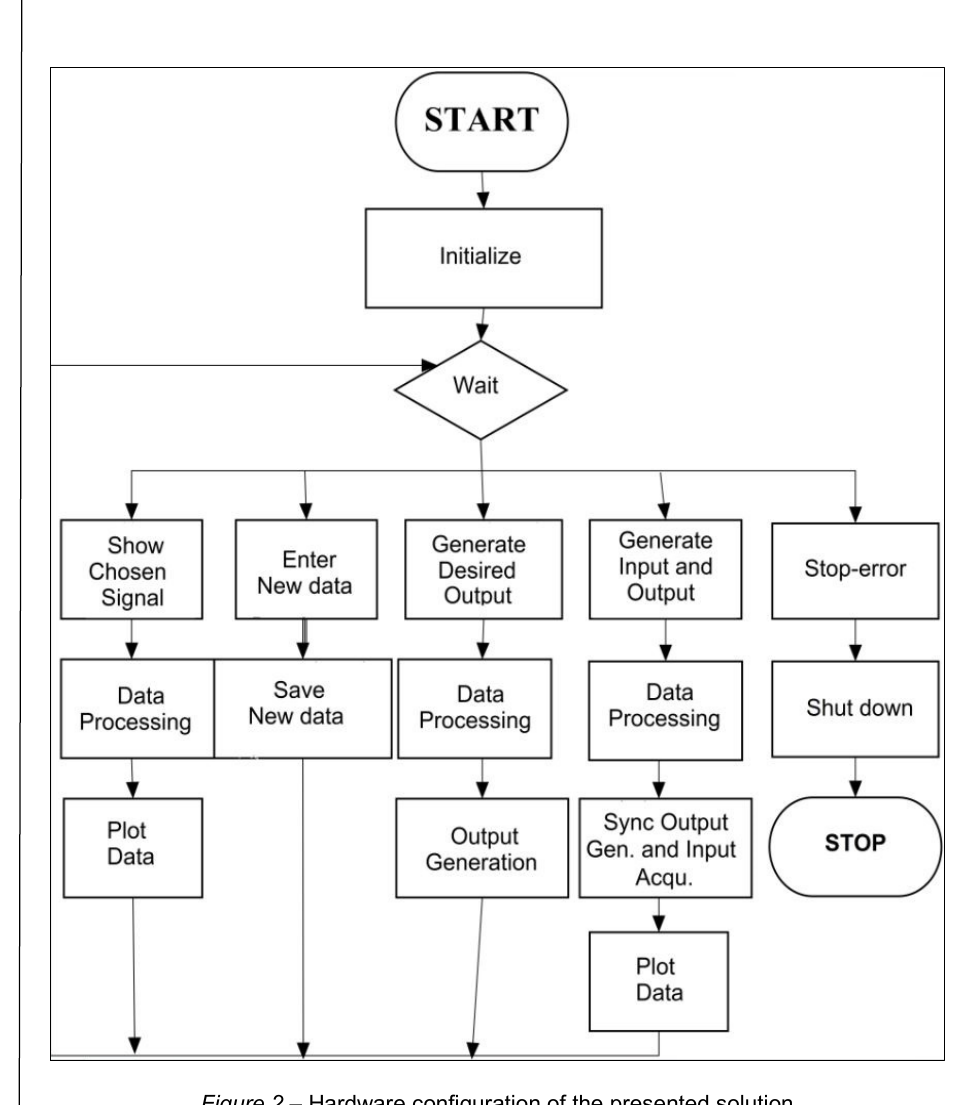
Figure 2 – Hardware configuration of the presented solution Рис . 2 – Конфигурация оборудования представленного